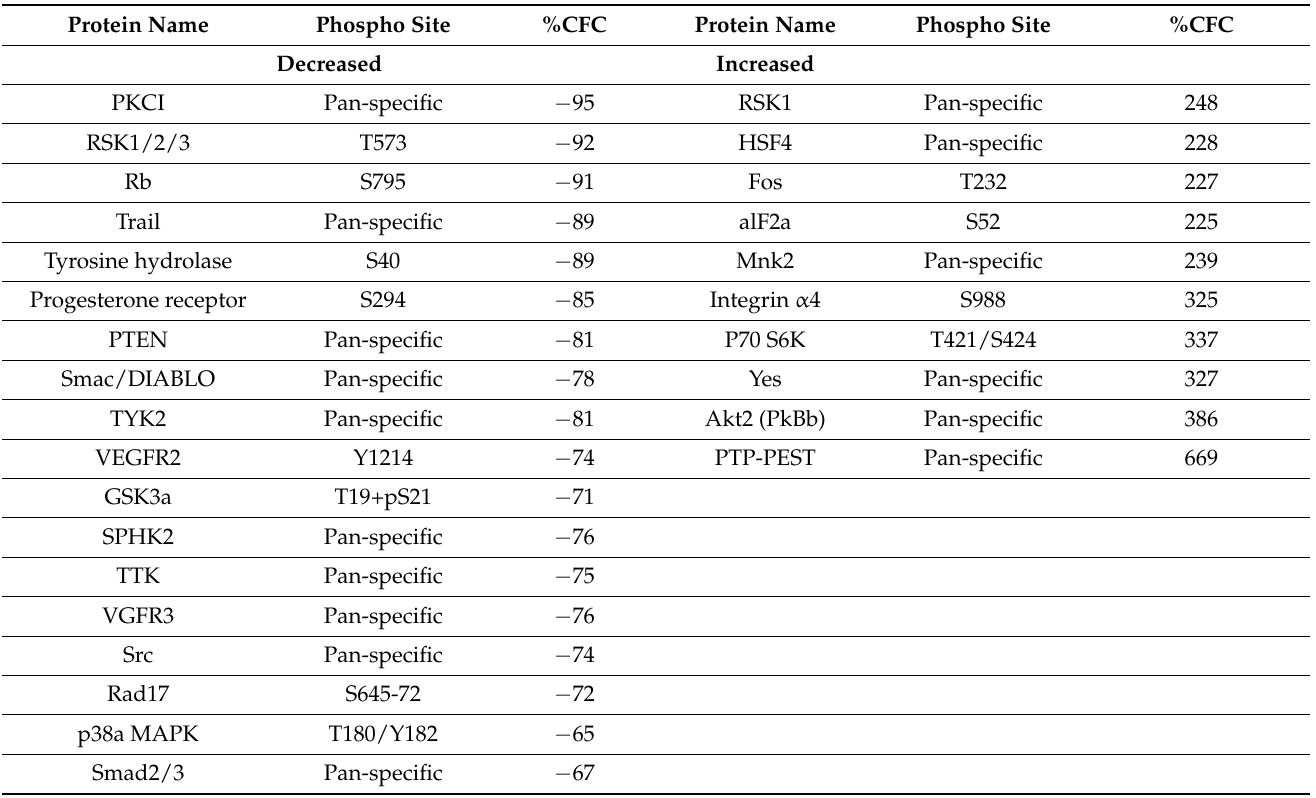
Significant changes in protein expression and phosphorylation following the wiskostatin